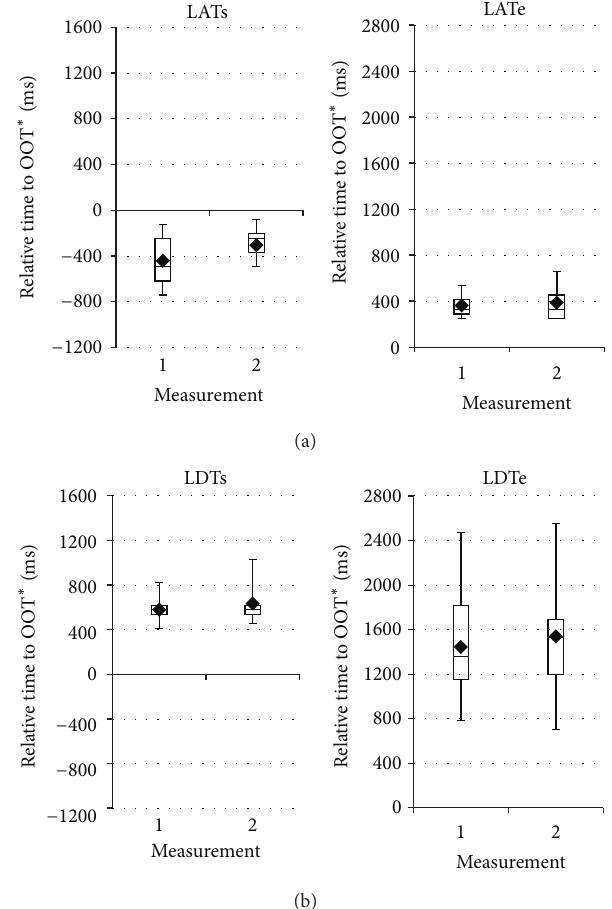
Figure 4: Start and end times of laryngeal ascent (LAT) and descent (LDT) for two repetitive real-time MRI measurements (means and quartiles, 10